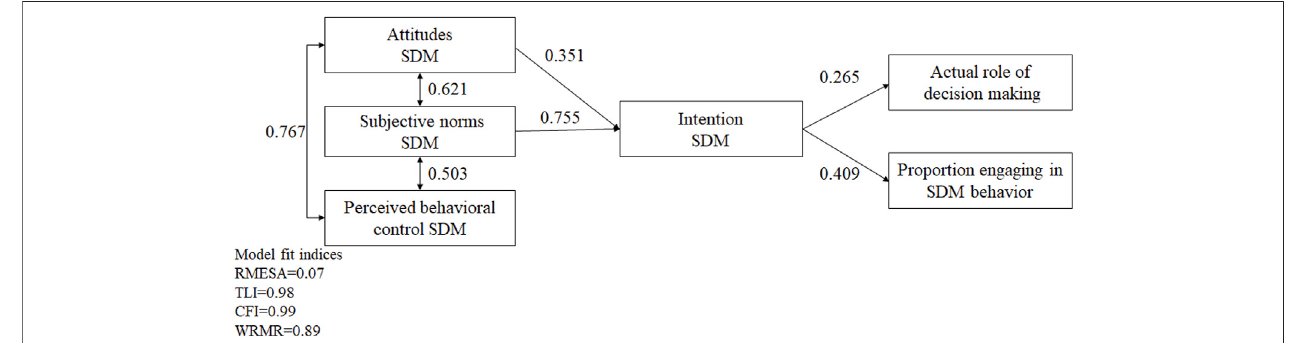
FIGURE 1 | The TPB theoretical framework for shared decision-making with patients with ARIs. Figure 1 describes the results of fi ve hypotheses of shared decision-making based on the theory of planned behavior.